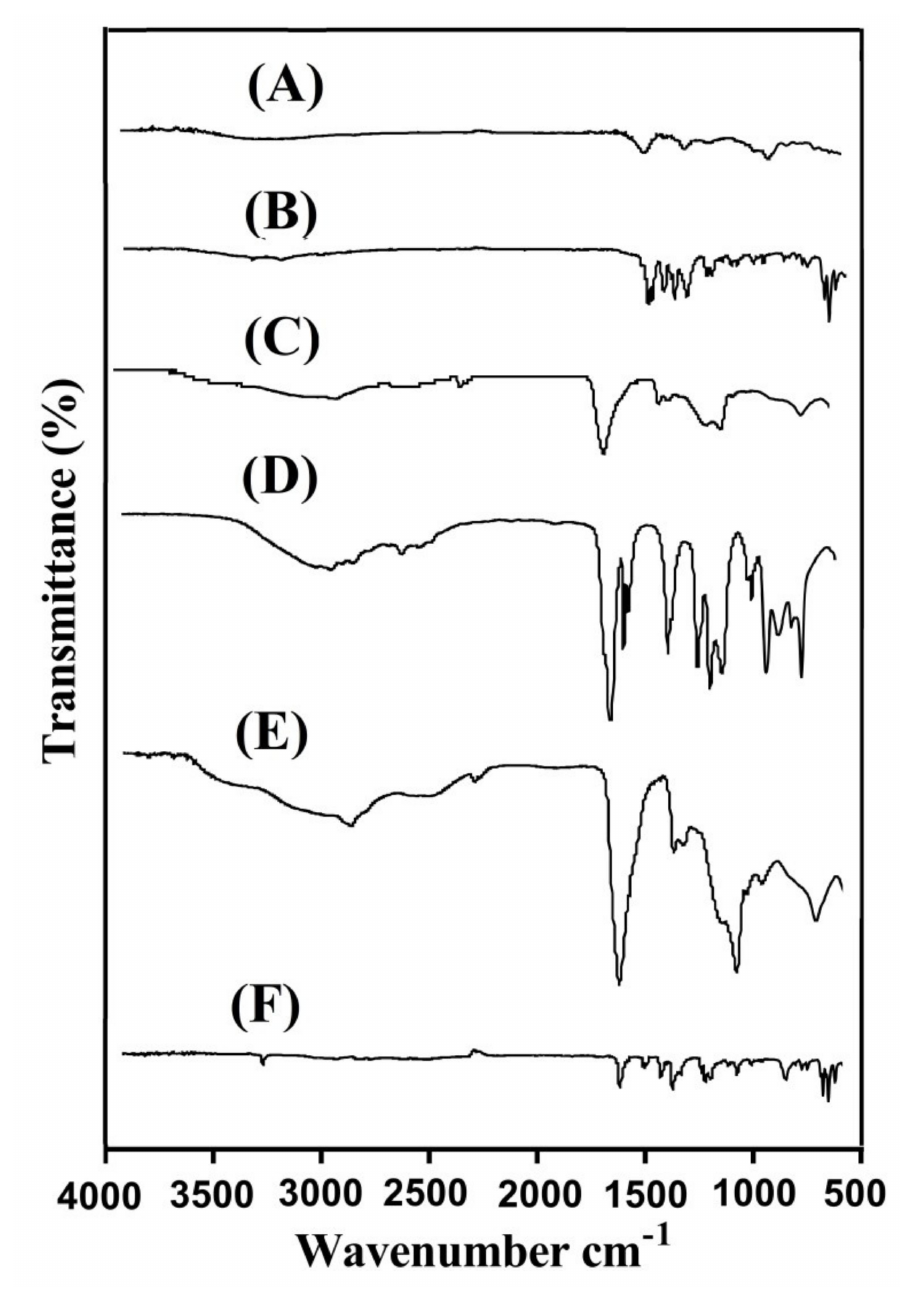
Figure 5. FTIR (Fourier transform infrared spectroscopy) spectra of ( A ) DS (Diclofenac sodium), ( B ) CS (Chondroitin sulfate), ( C ) CBP (Carbopol), ( D ) AA (Acrylic acid), ( E ) unloaded CS/CBP-co- PAA hydrogels, and ( F ) loaded CS/CBP-co-PAA